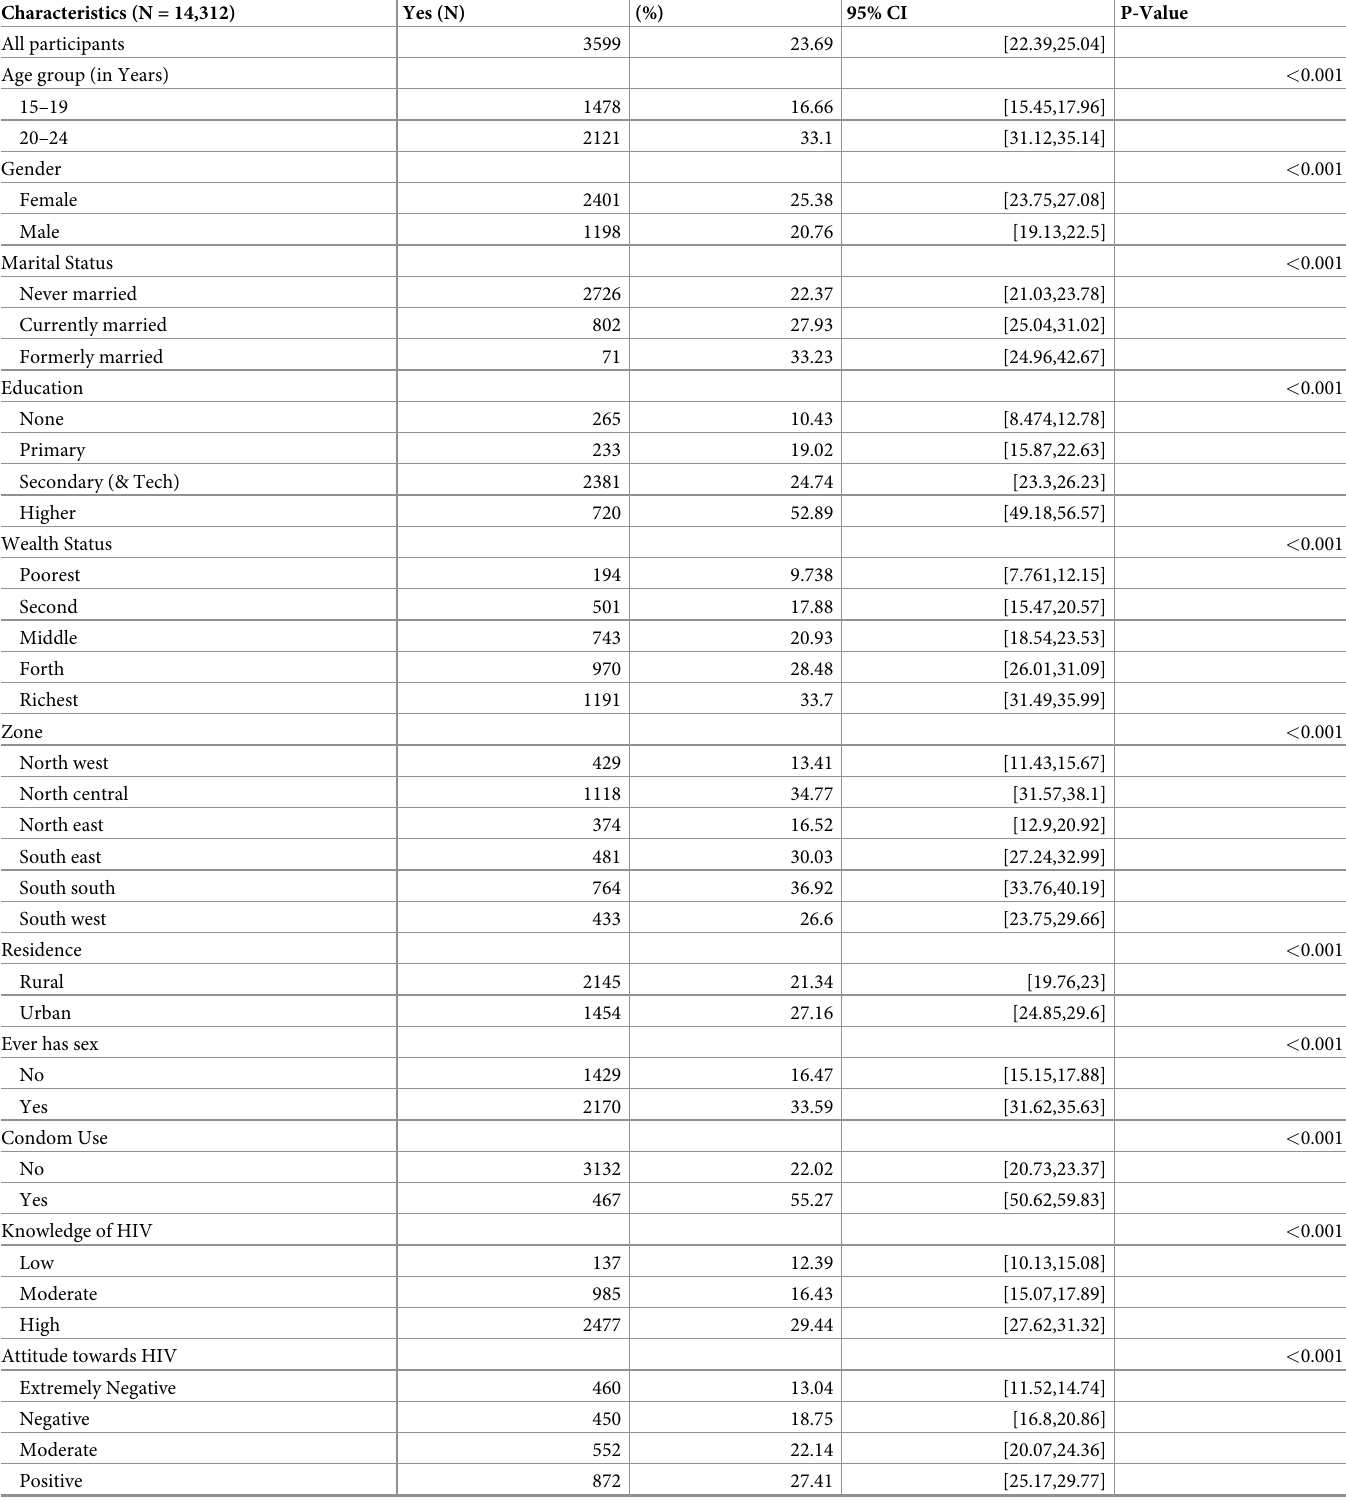
Table 2. Weighted proportions of adolescents who have ever tested for HIV by demographic, behavioural, social and contextual factors. Characteristics (N =